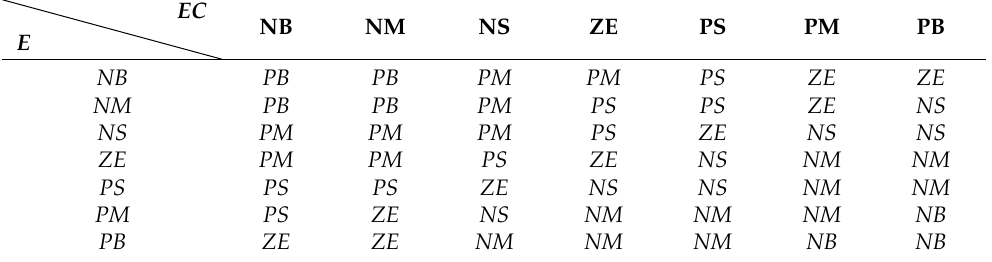
Table 1. ∆ K P Fuzzy rules table.